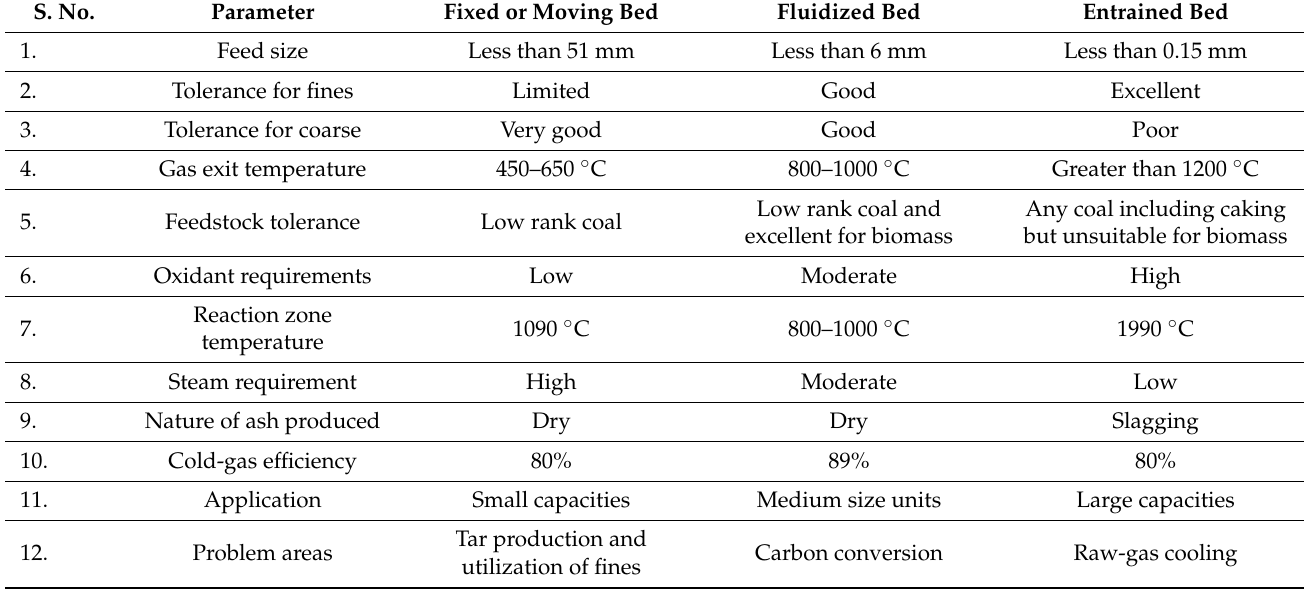
Table 4. Major differences between the gasifier